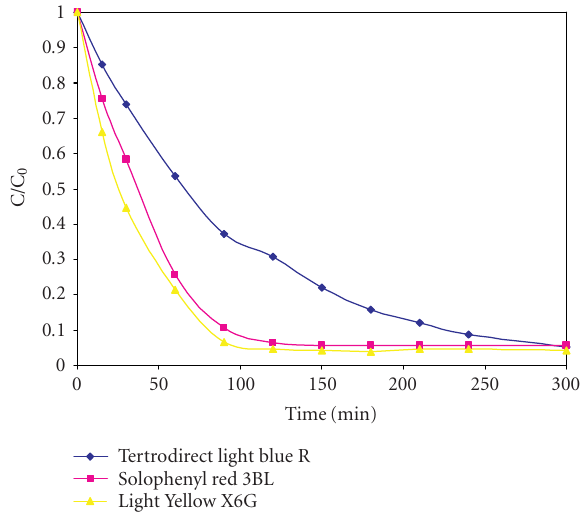
Figure 5: Graph C/C 0 versus time, t (min) for the removal e ffi - ciency of di ff erent types of dyes. One piece of composite TiO 2 with MC/glass, two pieces of blue fluorescent lamp, 10mL of each dye solution with initial pH 6 . 0, initial concentration of 10ppm, and temperature (28 ◦ C).